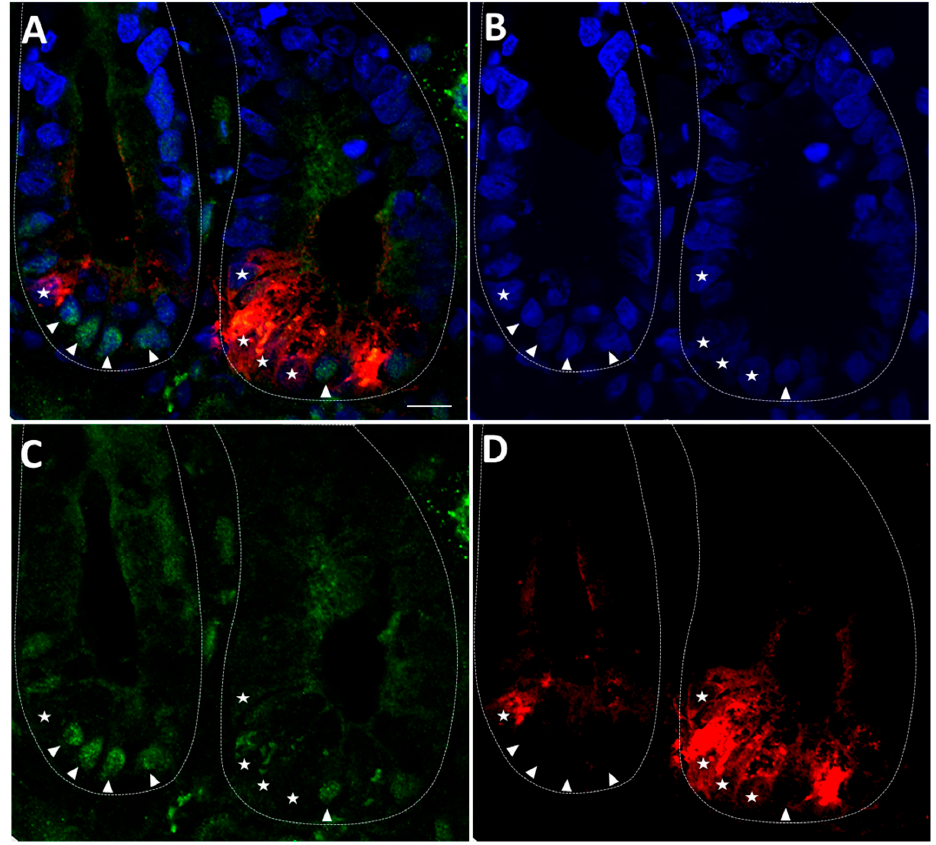
Figure 1. Nuclear expression of YAP1/TAZ in human intestinal crypt cells. Representative confocal imaging for the detection of YAP1/TAZ (green) ( A , C ), DEFA5 (red) ( A , D ) and DAPI (blue) ( A , B ) in the adult small intestine. Nuclear expression of YAP1/TAZ in some of the cells located at the bottom of the crypts was observed (arrowheads) except in Paneth cells (stars). Scale bar is equal to 10 μ m.